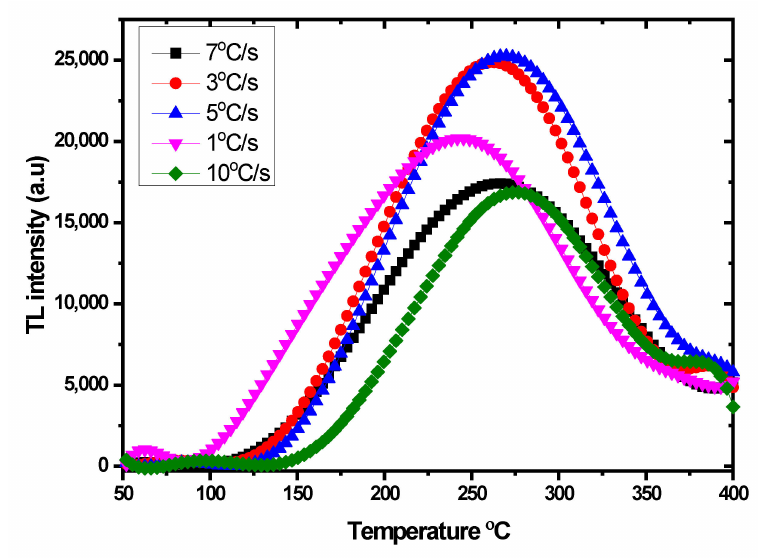
Figure 9. Glow curve of Ag-doped ZnO thin films as a function of heating rate.